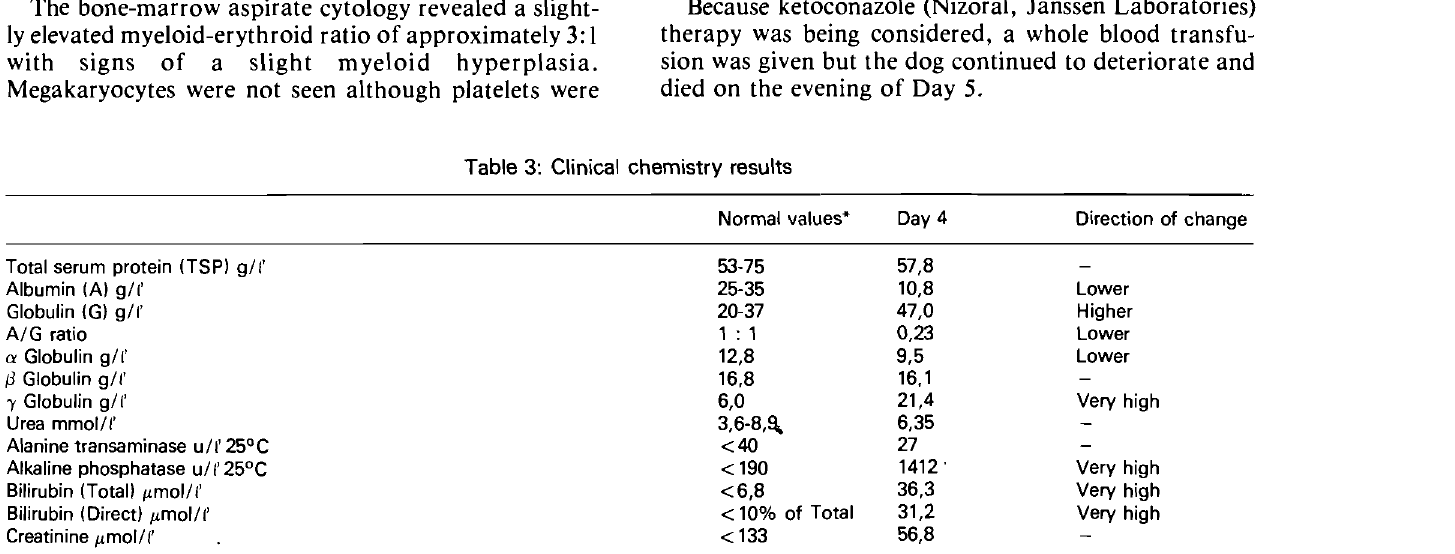
Table 3: Clinical chemistry